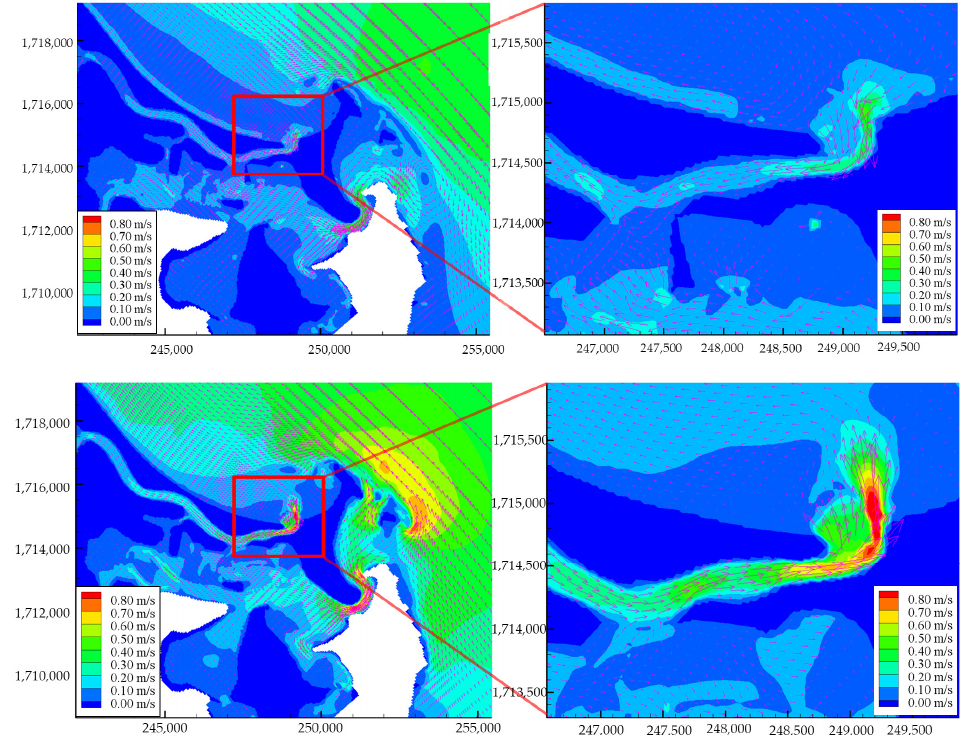
Figure 13. Current field in the flood tide ( upper panel) and ebb tide ( lower panel) during the Northeast monsoon under current condition.